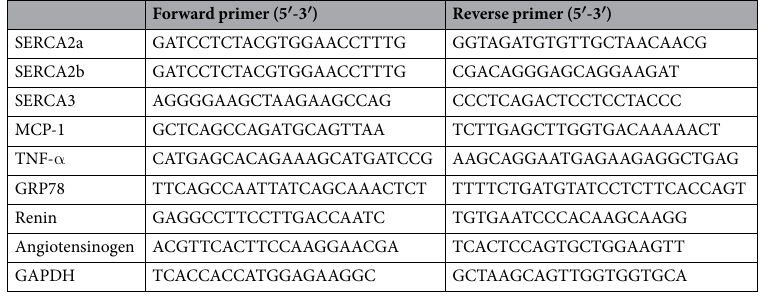
Table 2. List of primers used for